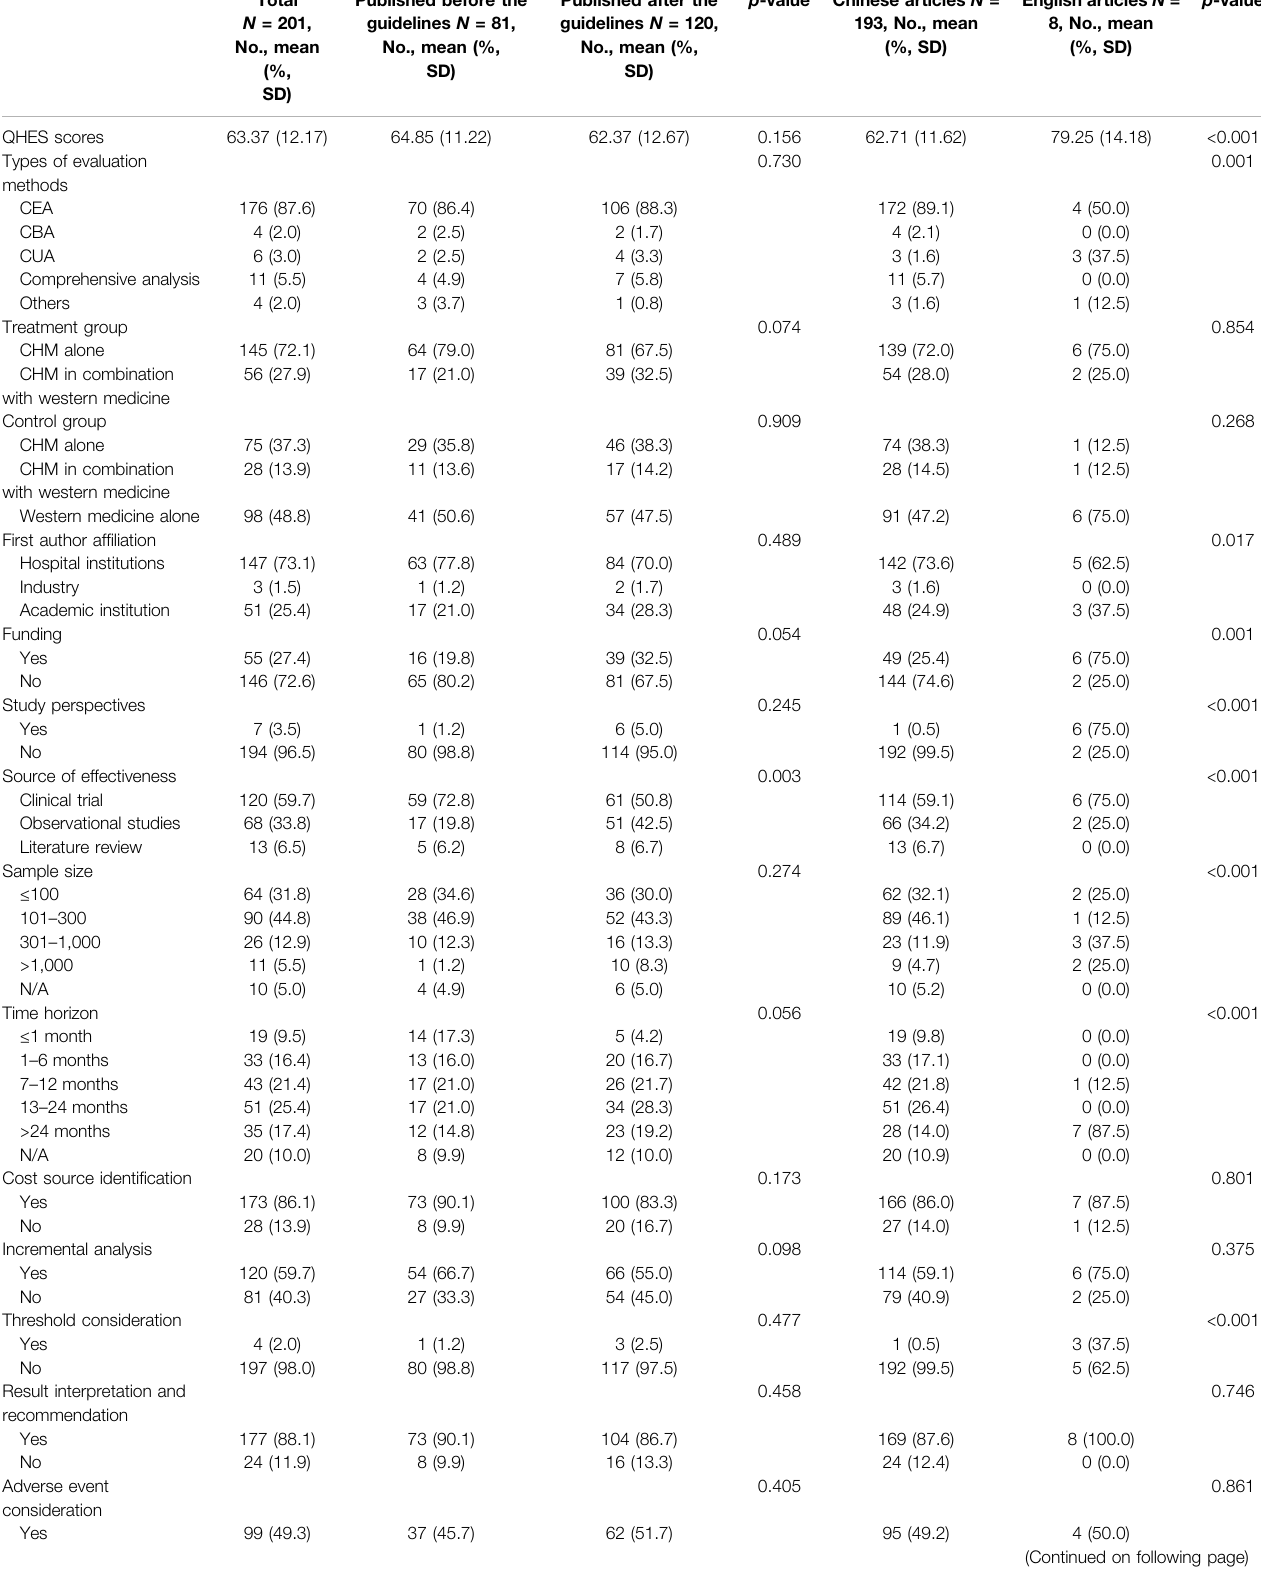
TABLE 1 | Comparison of characteristics of the included studies before and after the publication of the China PE